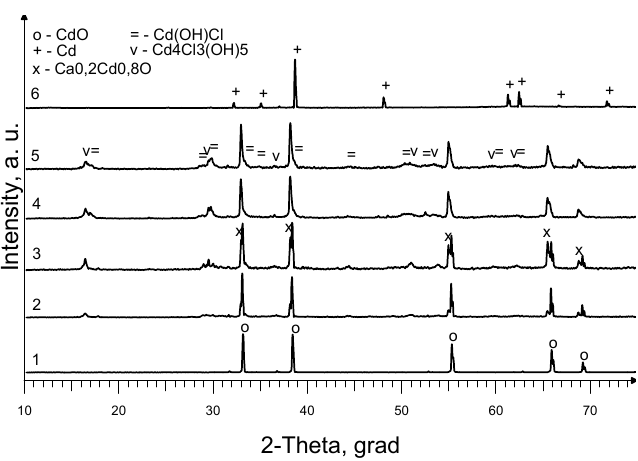
Figure 8. XRD patterns of samples: 1, initial mixture CdO + C; 2, CD6-1; 3, CD6-2; 4, CD6-4; 5, CD6-5; and 6, CD6-6.